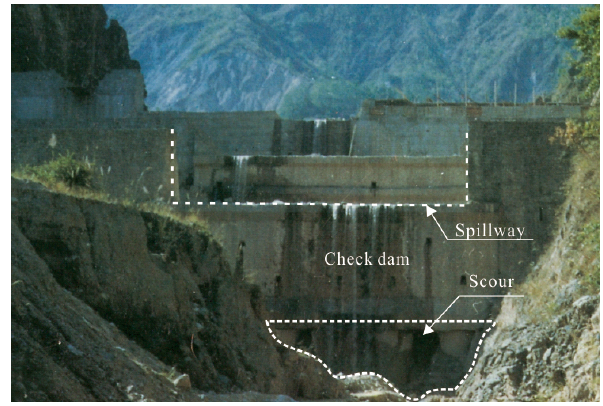
Figure 1. An example of foundation scour downriver of a check